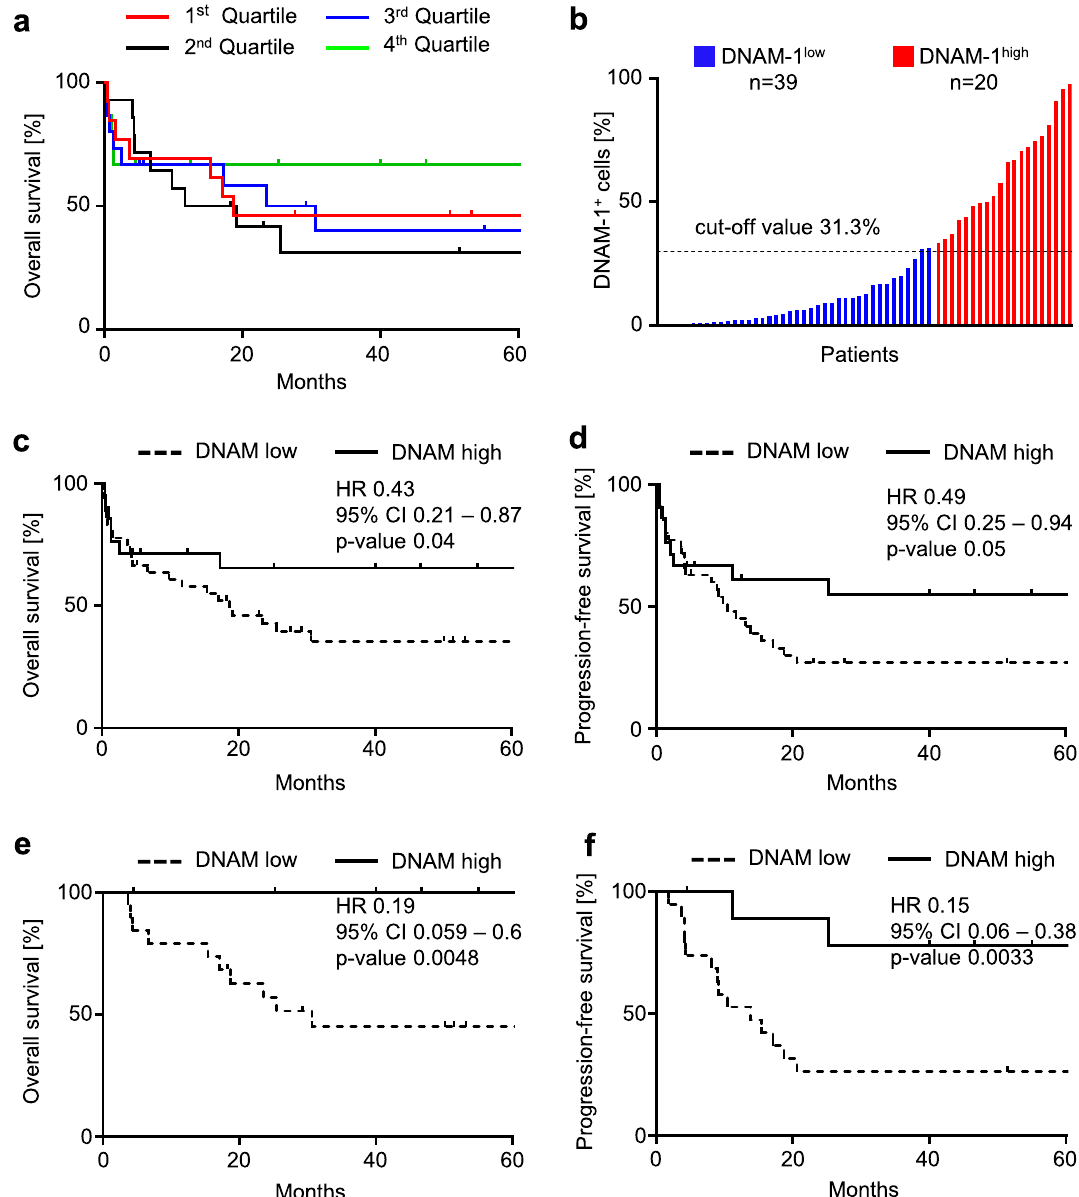
Figure 4. Prognostic evaluation of DNAM-1 in AML. ( A ) Overall survival of patients divided into quartiles according to DNAM-1 expression is depicted. ( B ) Separation of the cohort into DNAM-1 high and DNAM- 1 low groups using cut-off value of 31.5% positive cells is illustrated. ( C , D ) Overall and progression-free ( E , F ) survival of patients assigned to the DNAM high and DNAM low groups based on the cut-off value 31.3%; ( C , D )— all patients, ( E , F )—patients subjected to allogeneic stem cell transplantation (HSCT) is shown; statistical significance was assessed using log-rank